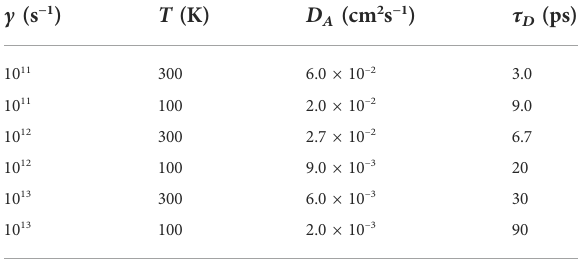
TABLE 3 Calculated intrachain adiabatic exciton diffusion coef fi cients, D A , and times, τ D , in PPP from Ref. [77]. τ D is the time taken for an exciton to diffuse along a chromophore of linear size 6 nm in a solvent at temperature, T , with a damping rate γ . From simulations [77], τ D ~ γ 1/2 / T . Hegger et al. [80] obtained D A ~ 10 – 2 cm 2 s − 1 in oligothiophenes at 300 K and γ = 5 × 10 12 s − 1 .